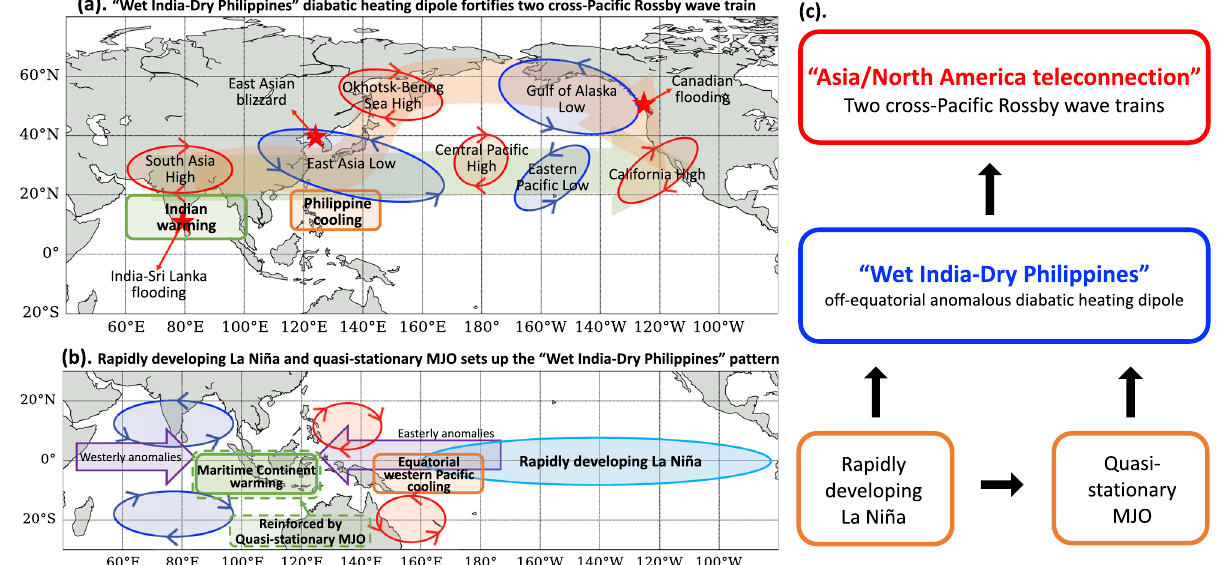
Fig. 6 Summary schematics. a the Asian/North American teleconnection organizing the cluster of sequential extreme precipitation events, b the “ wet India-dry Philippine ” diabatic heating generated by rapidly developed La Nina and quasi-stationary MJO, and c the causality